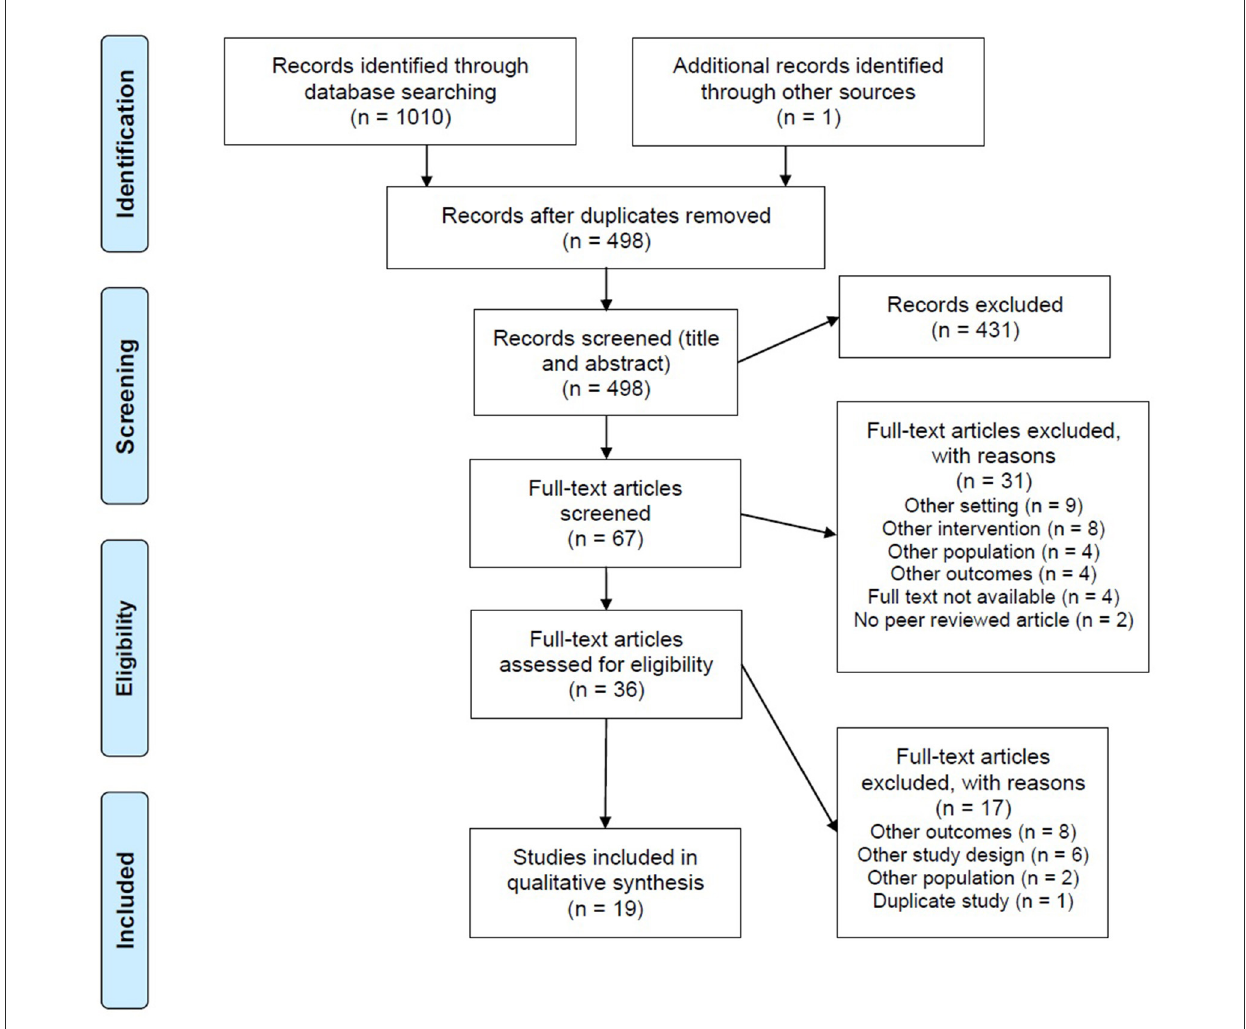
FIGURE1 Flow diagram of the study screening and selection.